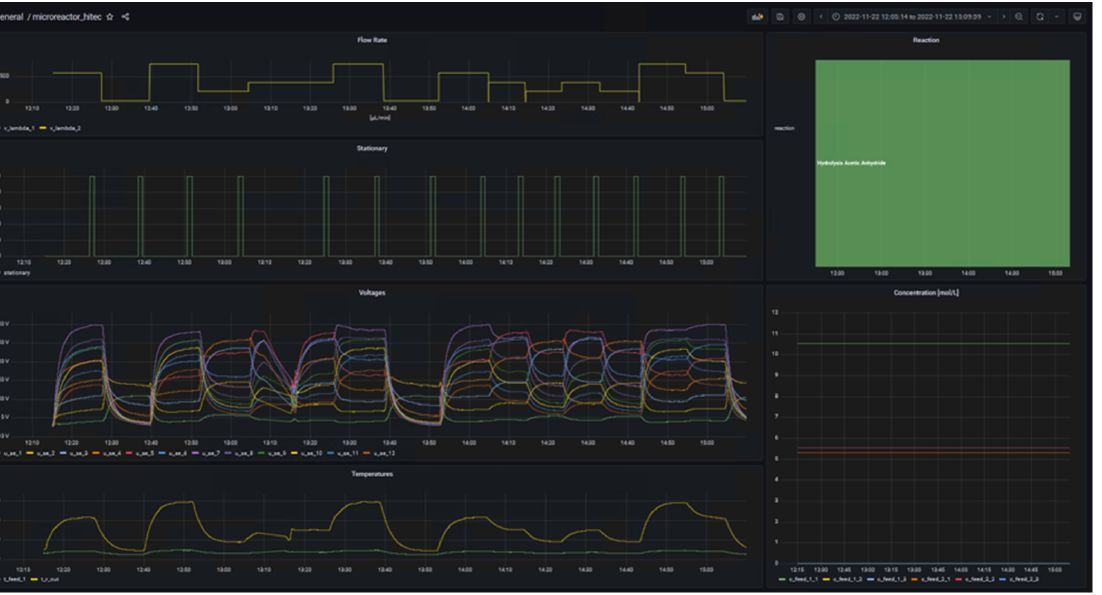
Figure 4. Dashboard for visualization of experimental data during calorimetric measurements such as volumetric flow rates and temperatures.